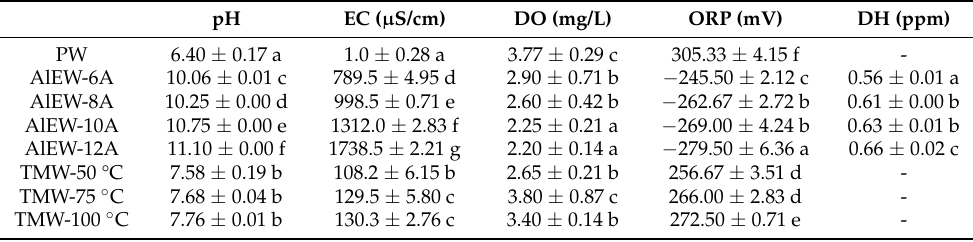
Table 1. The physical and chemical parameters of sample waters 1 . pH EC ( µ S/cm) DO (mg/L) ORP (mV) DH (ppm)